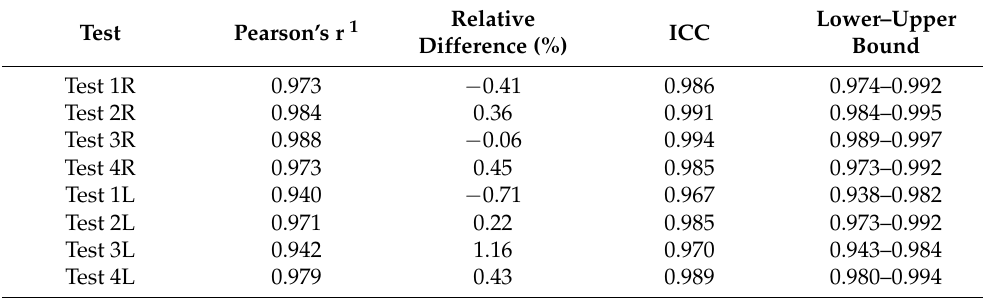
Table 2. Pearson’s correlation coefficients r , relative differences, and interclass correlation coefficients ICC for tests run times measured by the FitLight Trainer and IMU device for all four tests and both active legs.